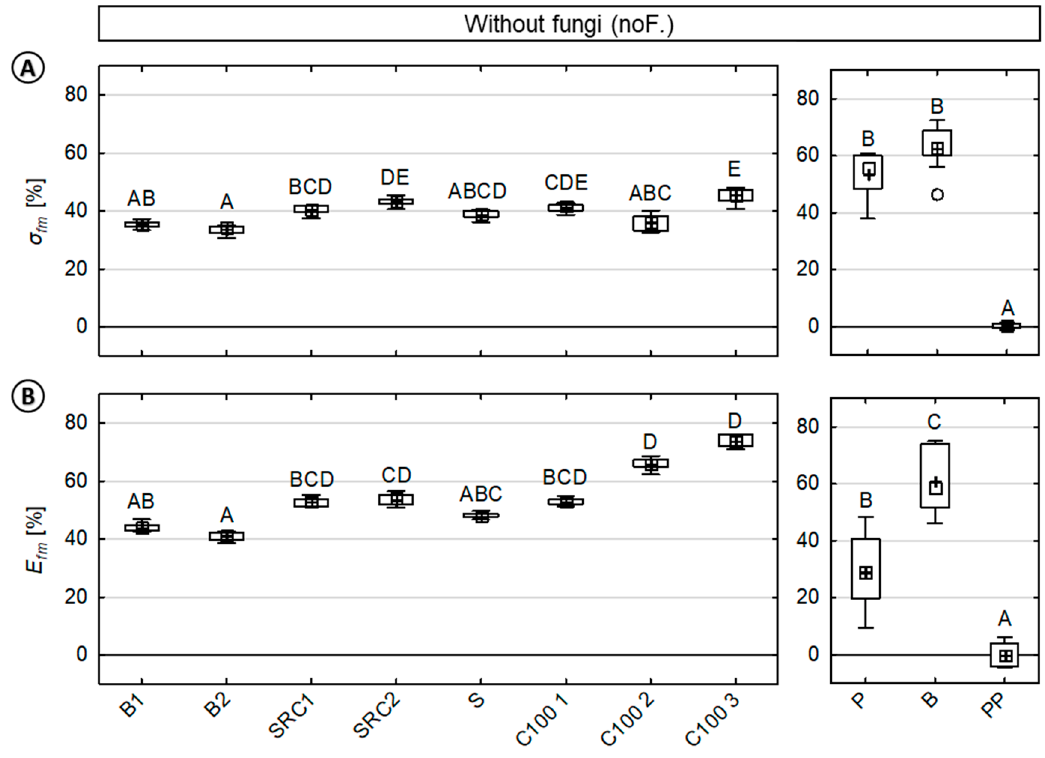
Figure 5. Percentage loss in ( A ) MOR ( σ fm ) and ( B ) MOE ( E fm ) of injection molded wood-polypropylene composites caused by moisture during the test procedure. (Right) For direct comparison, percentage loss in the MOR and MOE of reference materials (beech wood, pine sapwood, and polypropylene) are shown, respectively. Results of the statistical analyses are displayed, whereas values assigned with the same letter are not significantly different from each other at a significance level of α = 0.05. (Kruskal–Wallis).